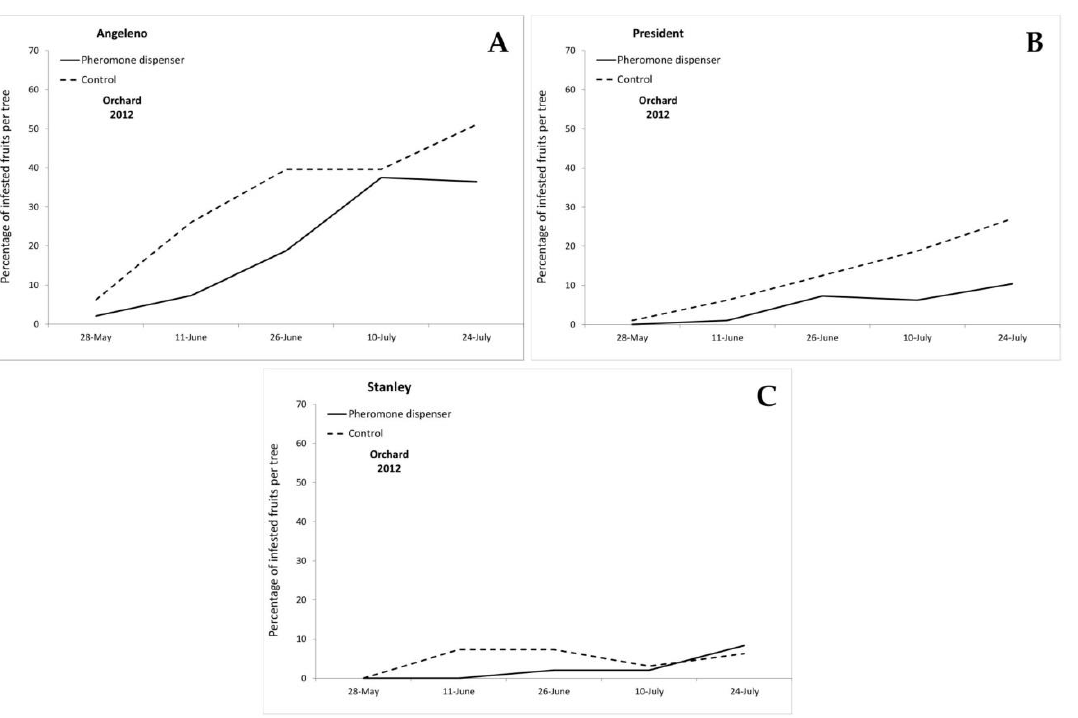
Figure 2. Infestation trend (mean percentage of infested fruits per tree) recorded in 2012 in the cultivars ( A ) Angeleno, ( B ) President and ( C ) Stanley.